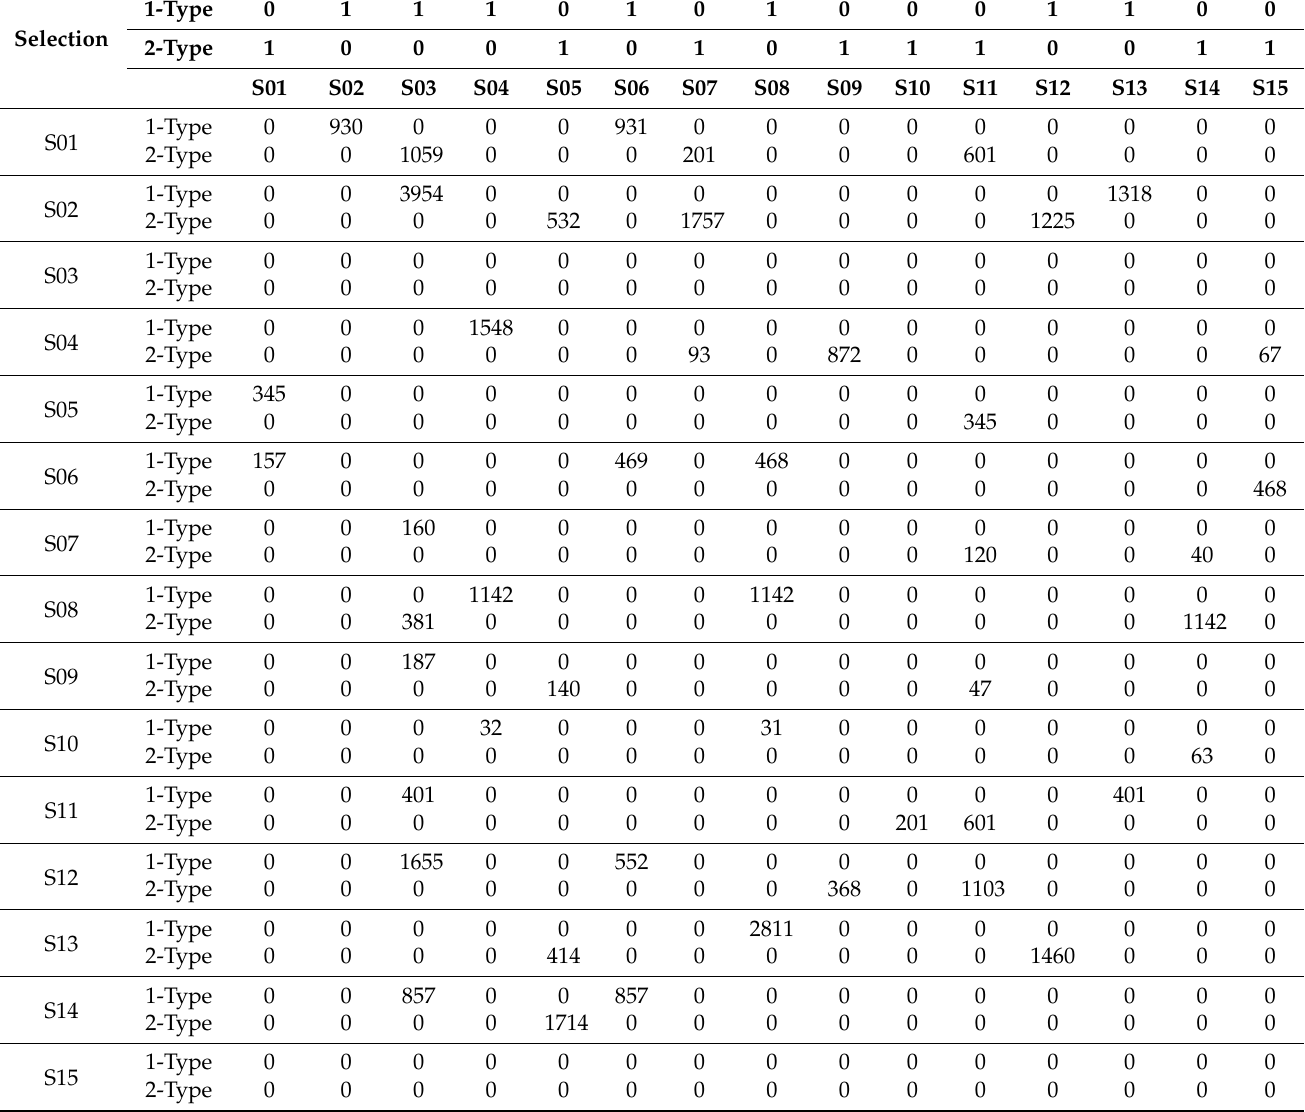
Table 18. Solution with the maximum number of short-term shelters to be